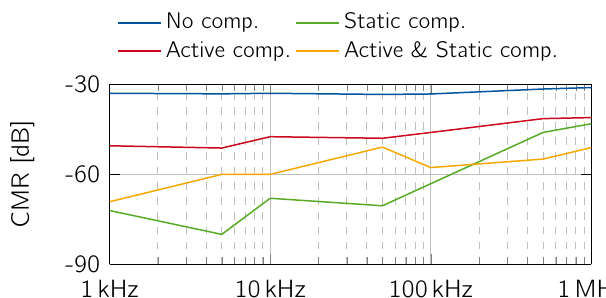
Figure 13: CMR of the EHCS: The static compensation (green) has a performance loss above 100 kHz, where active compensation (red) and combined compensation (yellow) achieve a more constant CMR over the whole frequency range.